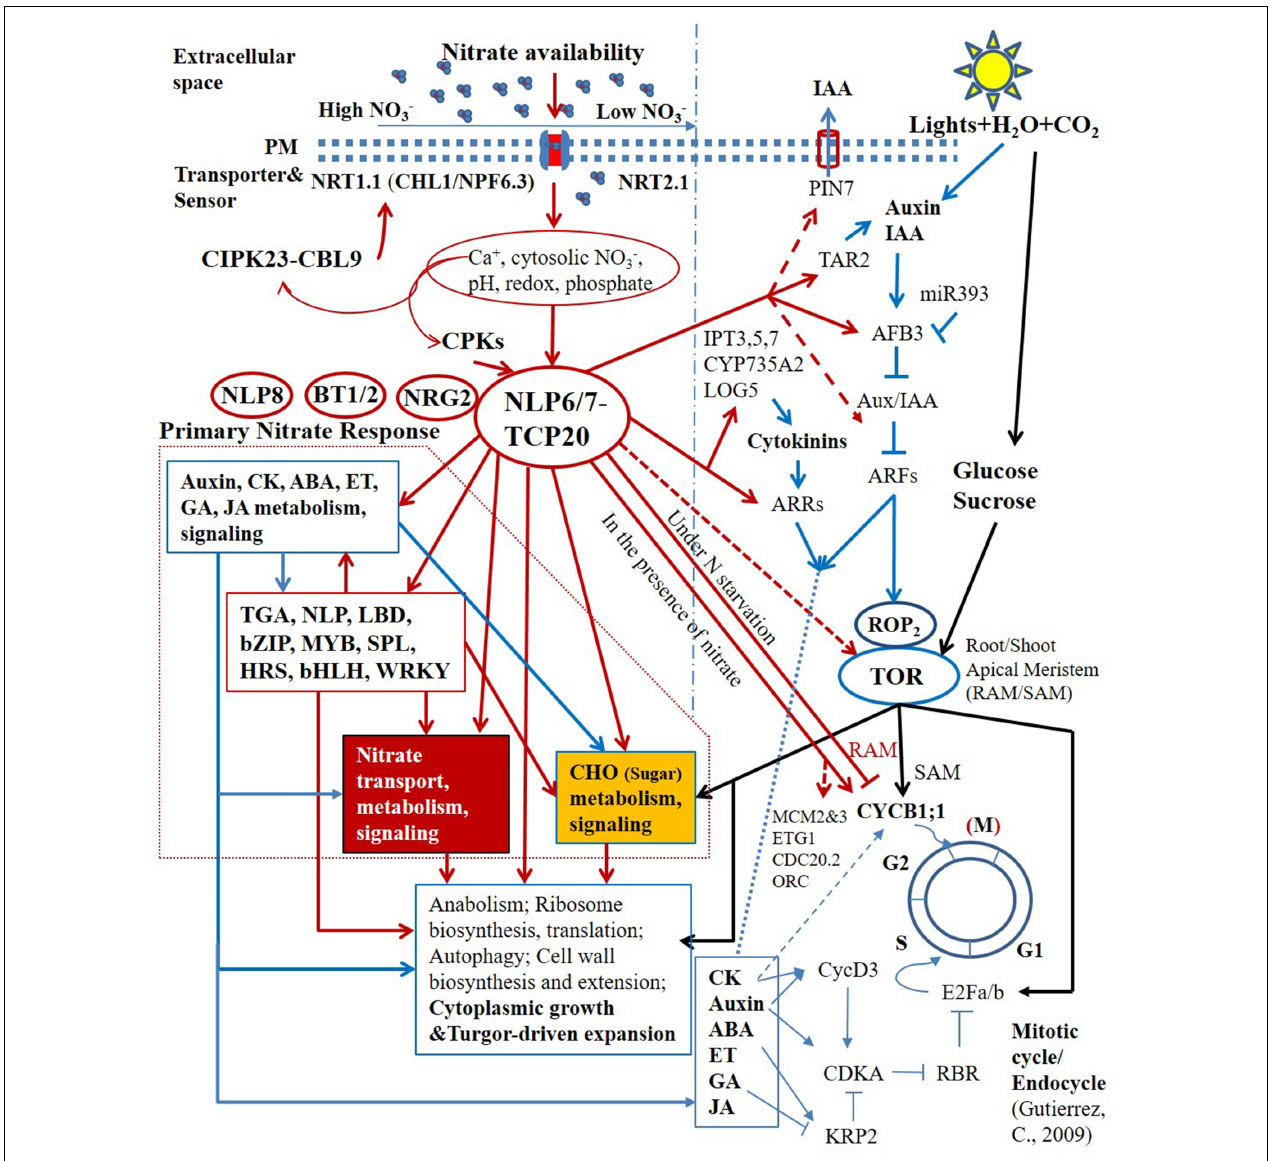
FIGURE 2 | Schematic representation of the central regulatory role of TCP20-NLP6/7 complexes in nitrate transcriptional hierarchy and nutrient-growth networks. Arrows and blunted lines represent positive and inhibitory regulations, respectively. Solid lines indicate defined pathways, whereas dashed lines indicate presumed or initially confirmed